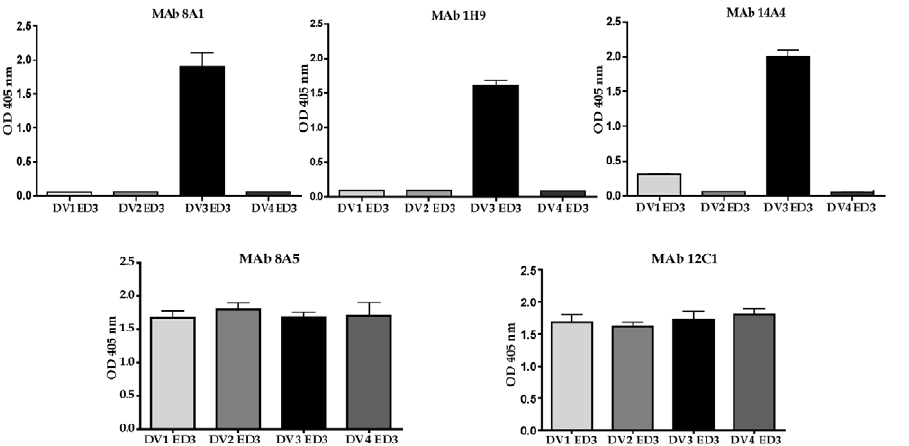
Figure 3. Binding of mouse MAbs to recombinant EDIII from the 4 serotypes of DENV. MAb binding was detected by ELISA. MAbs 8A1 and 1H9 bound to EDIII from DENV3 only. MAb 14A4 bound to EDIII from DENV3 and to a lesser extent to EDIIII from DENV1. MAbs 8A5 and 12C1 bound to EDIII from all 4 serotypes.